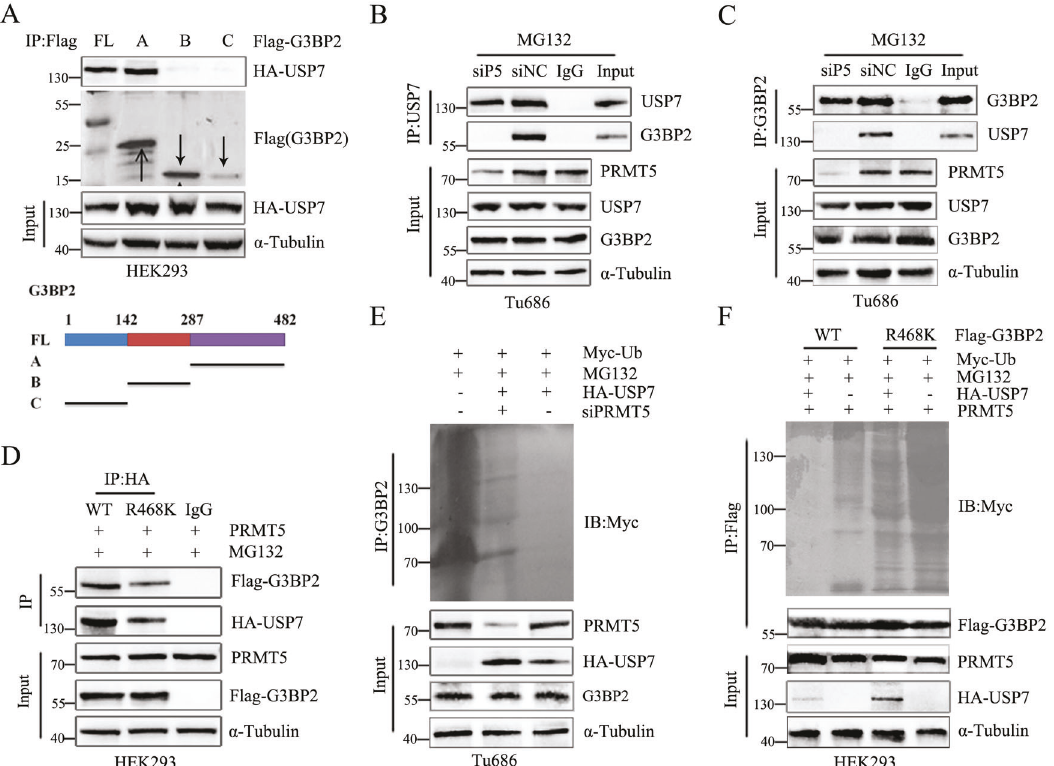
Fig. 3 PRMT5 augment G3BP2 binding with and deubiquitination by methylation. A A series of G3BP2 constructs were co-transfected with HA-USP7 plasmid into HEK293 cells. Cell lysates were immunoprecipitated with anti-Flag antibody and then analyzed by immunoblotting with HA-USP7 antibody. B , C Tu686 cells were transfected with either negative control siRNA or PRMT5 siRNA, then treated with 40 μΜ MG132 for 6 h. Cell lysates were immunoprecipitated with anti-USP7 or G3BP2 antibody, followed by immunoblotting analysis. D Flag-G3BP2 wild type or R468K mutant was co-transfected with PRMT5 and HA-USP7 into HEK293 cells, and then treated with MG132 for 6 h. Cell lysates were immunoprecipitated with anti-HA antibody then analyzed by immunoblotting using anti-Flag antibody. E Cells were transfected with Myc-Ub and HA-USP7 and negative control siRNA or PRMT5 siRNA, followed by treated with MG132 for 6 h. Cell lysates were immunoprecipitated with anti-G3BP2 antibody then analyzed by immunoblotting. F Flag-G3BP2 wild type or R468K mutant, Myc-Ub and PRMT5 were co-transfected into HEK293 cells, and then treated with MG132 for 6 h. Cell lysates were immunoprecipitated using anti-Flag antibody and then analyzed by immunoblotting using anti-Myc